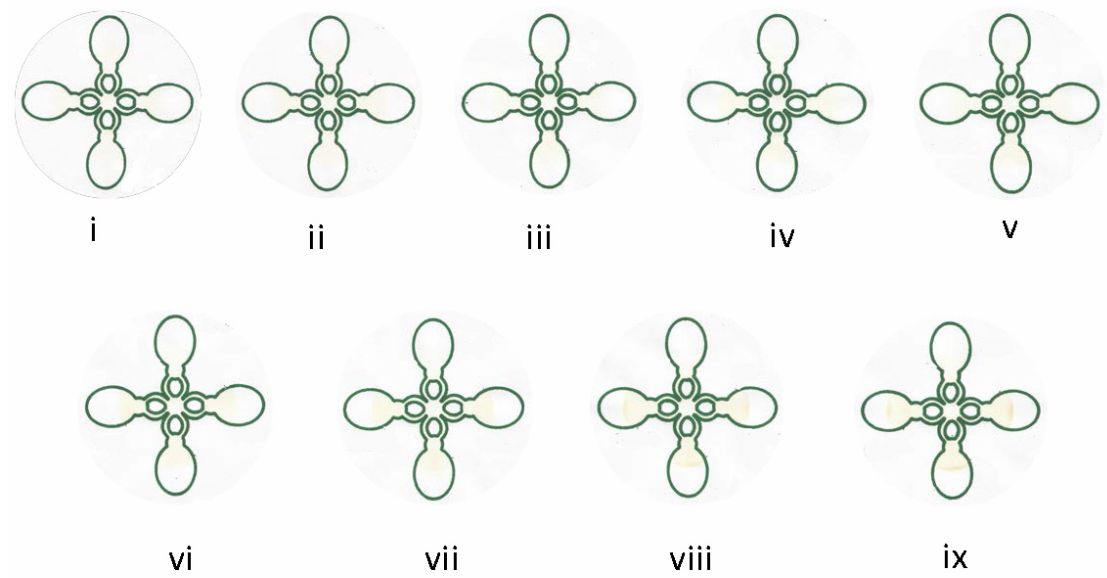
Figure 2. Digital photographic images of the glucose assay for the cloverleaf four-channel μPADs using a range ( i ) 0.6; ( ii ) 1.9; ( iii ) 2.5; ( iv ) 3.0; ( v ) 3.3; ( vi ) 4.4; ( vii ) 6.25; ( viii ) 9.20; and ( ix ) 12.1 mM of concentrations of glucose.